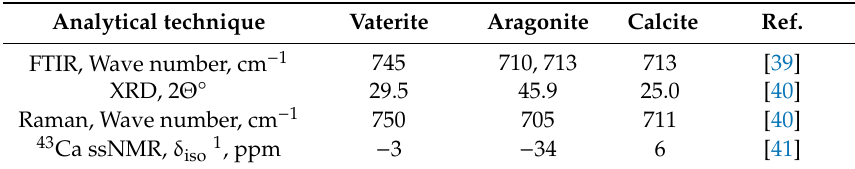
Table 2. Characteristic peaks of CaCO 3 polymorphs in FTIR, XRD, Raman spectroscopy, and 43 Ca ssNMR